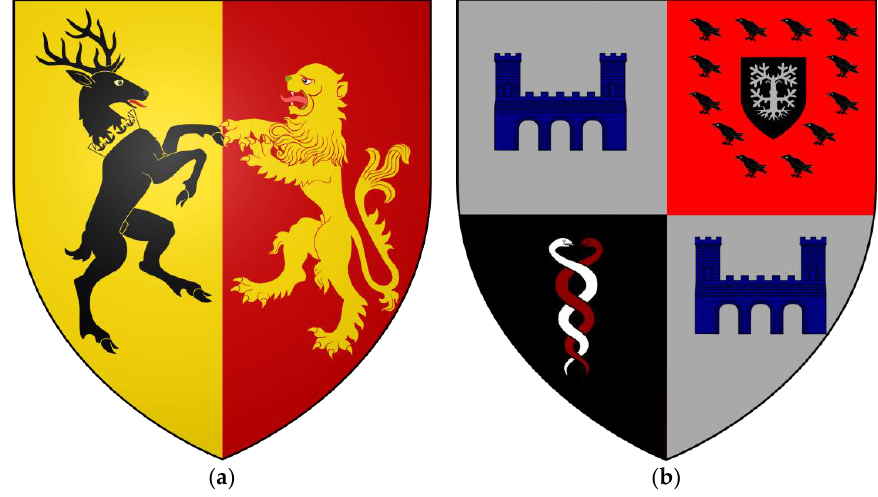
Figure 5. Rare cases of matrimonial marshalling: ( a ) The new royal line of Joffrey Baratheon impales the crowned stag of his Baratheon father with the lion of his Lannister mother (A Wiki of Ice and Fire: House Barrrratheon (King’s Landing).svg 2018); ( b ) The arms of ‘Big’ Walder Frey use the twin towers of his paternal house, quartered with the arms of his mother and grandmother (A Wiki of Ice and Fire: Big Walder Frey coa.png 2011).